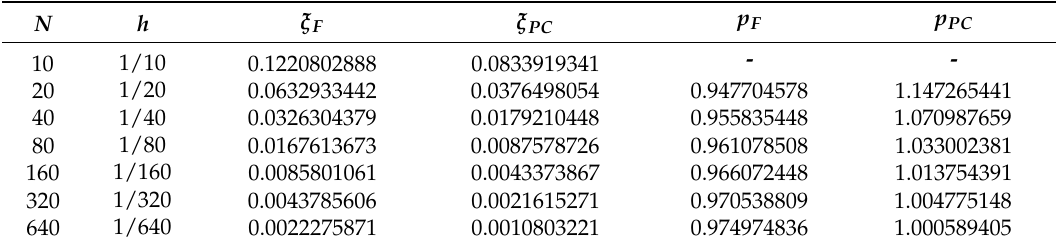
Figure 3. Numerical results using fractional Adams–Bashforth–Moulton (ABM) and explicit non-local finite-difference scheme (ENFDS) methods compared to exact solution (ES) for Example 2 at N = 20 and β = 1.8. Table 5. Error analysis of numerical methods for Example 2 ( β =